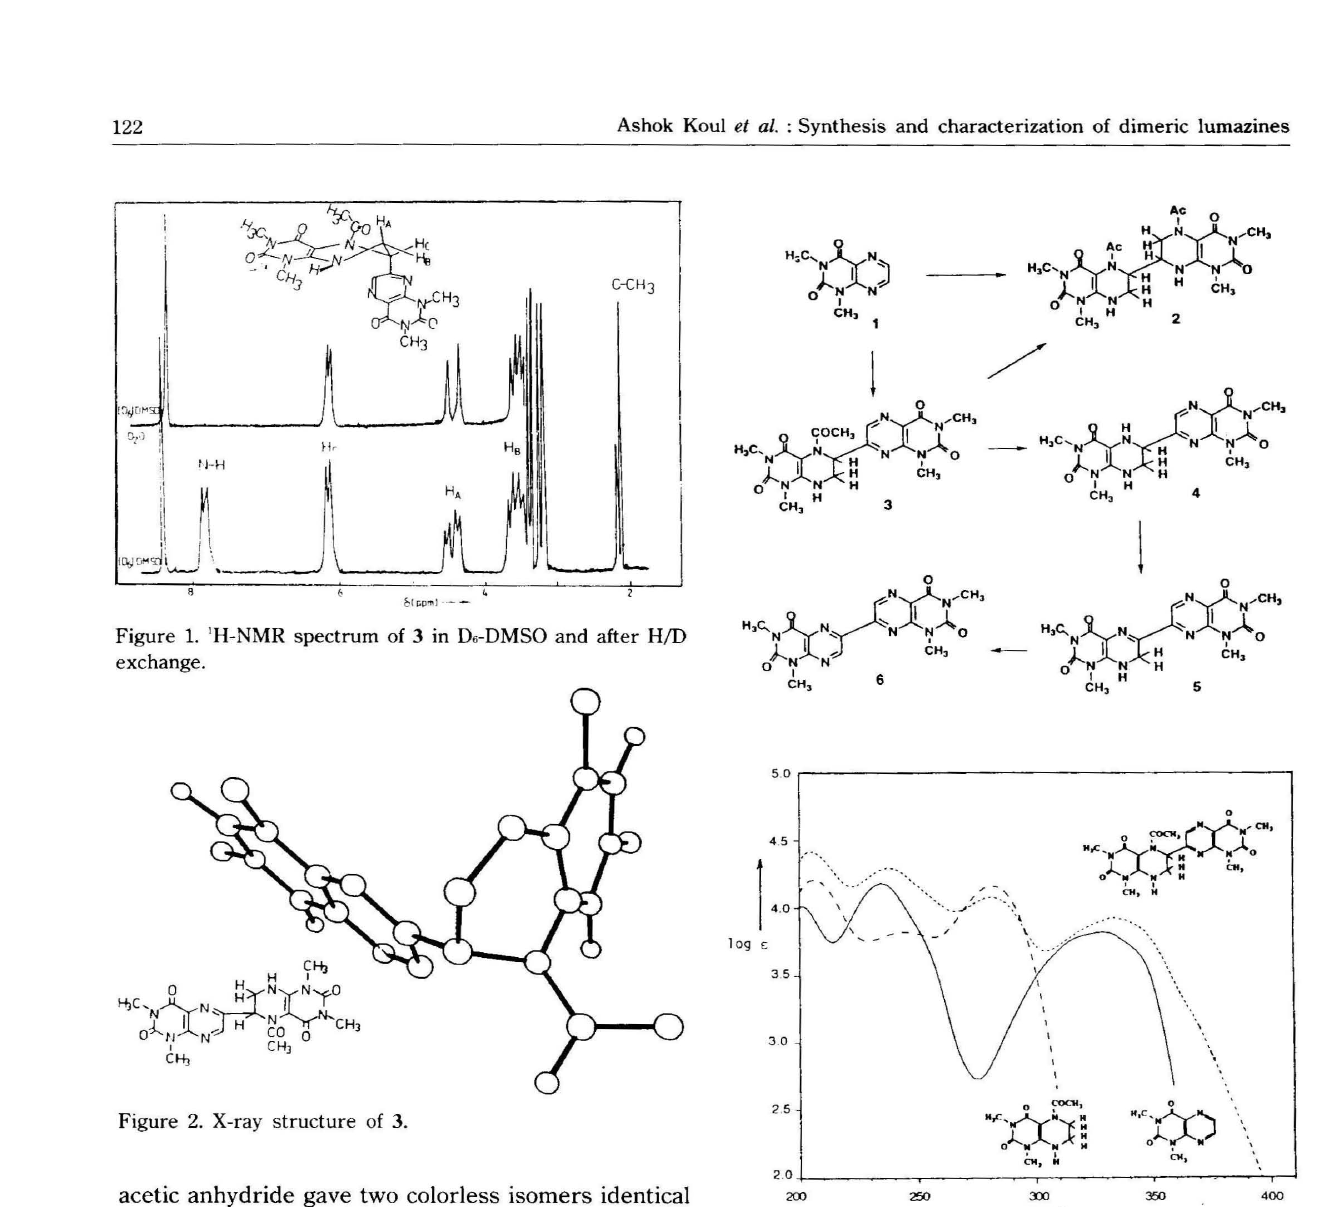
Figure 1. 'H-NMR spectrum of 3 in D6-DMSO and after HID exchange.